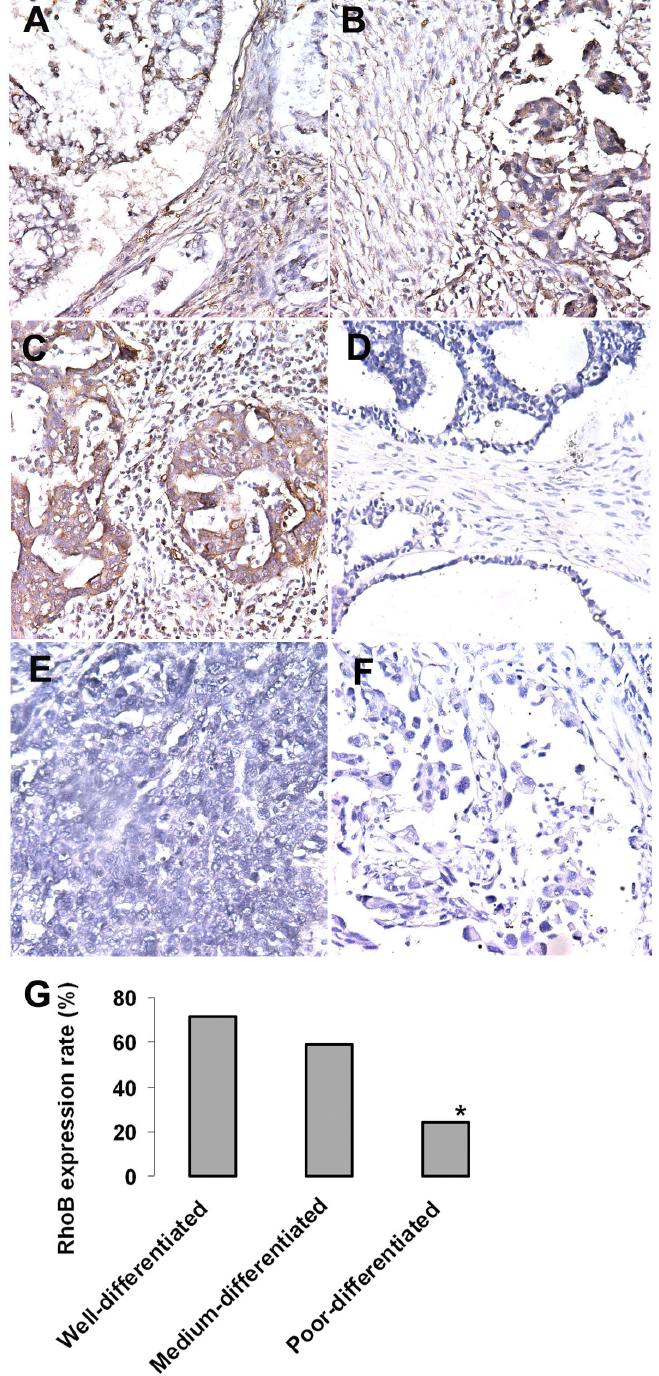
Figure 2. RhoB gene expression and ovary carcinoma differentiation. RhoB expression levels were analyzed respectively in well-, medium-, and poor-differentiated ovarian cancer using immunohistochemistry staining of individual paraffin sections. RhoB is expressed in the cytoplasm of monolayered ovarian surface epithelial cells for well-differentiated ovary caicinoma (AB); in medium- differentiated tumor, RhoB is expressed in the monolayered and multilayered regions of epithelium tumor (CD); and RhoB is lost in the multilayered region of epithelium for poor-differentiated tumor (EF). (G) It is clear that Poor-differentiated tumors had a significant reduction in the expression of RhoB (80% reduction) than medium differentiated (44% reduction) and well differentiated ovary cancer (28.5% reduction). doi: 10.1371/journal.pone.0078417.g002 PLOS ONE |